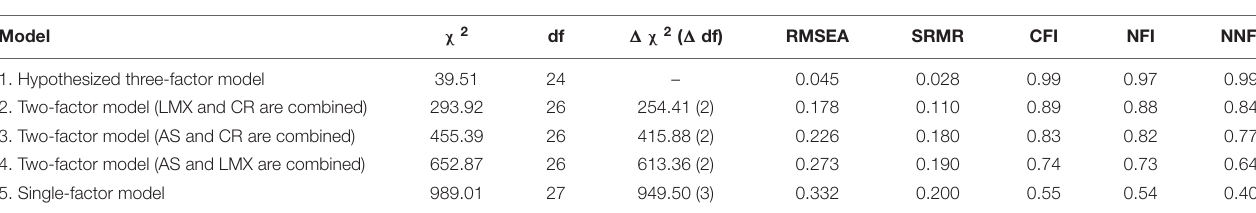
TABLE 2 | Model fit indices for confirmatory factor analysis.